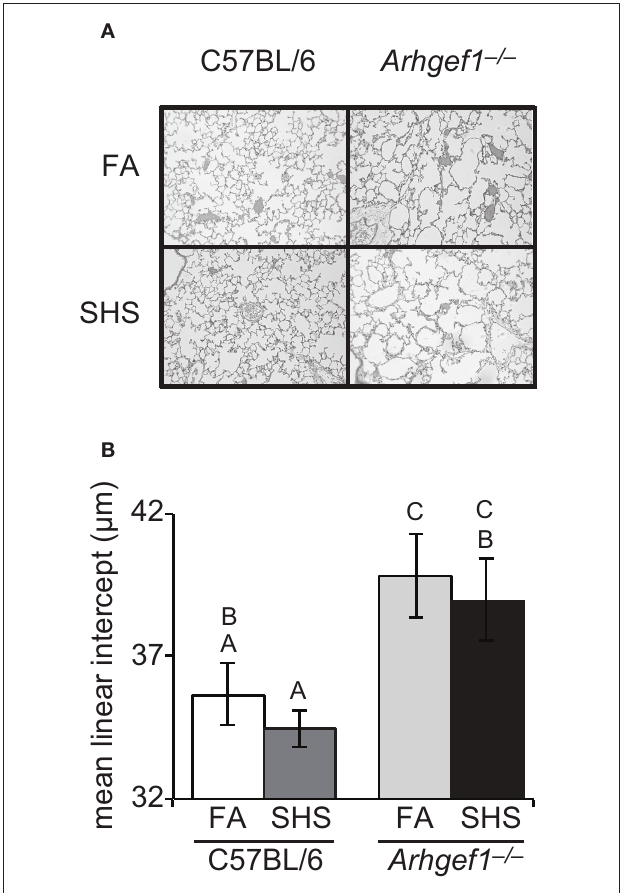
FIGURE 4 | Short term exposure to second hand cigarette smoke does not lead to airspace enlargement. Airspace structure was quantitated by mean linear intercept ( µ m) of alveolar septae as measured on inflated, hematoxylin and eosin-stained lung sections as described in materials and methods. (A) Representative lung tissue sections from C57BL6 animals (left column) or Arhgef1 − / − animals (right column) exposed to either filtered air (FA, top row) or second hand smoke (SHS, bottom row). (B) Mean linear intercept ( µ m) of 3 month old C57BL/6 mice exposed to filtered air (FA) (open bar, n = 7), 3 month old C57BL/6 mice exposed to second hand smoke (SHS) for 4 weeks prior to harvest (dark gray bar, n = 8), 3 month old Arhgef1 − / − mice exposed to FA (light gray bar, n = 9) and 3 month old Arhgef1 − / − mice exposed to SHS for 4 weeks prior to harvest (black bar, n = 7). A One-Way ANOVA was performed and significant differences were detected between groups. A post hoc